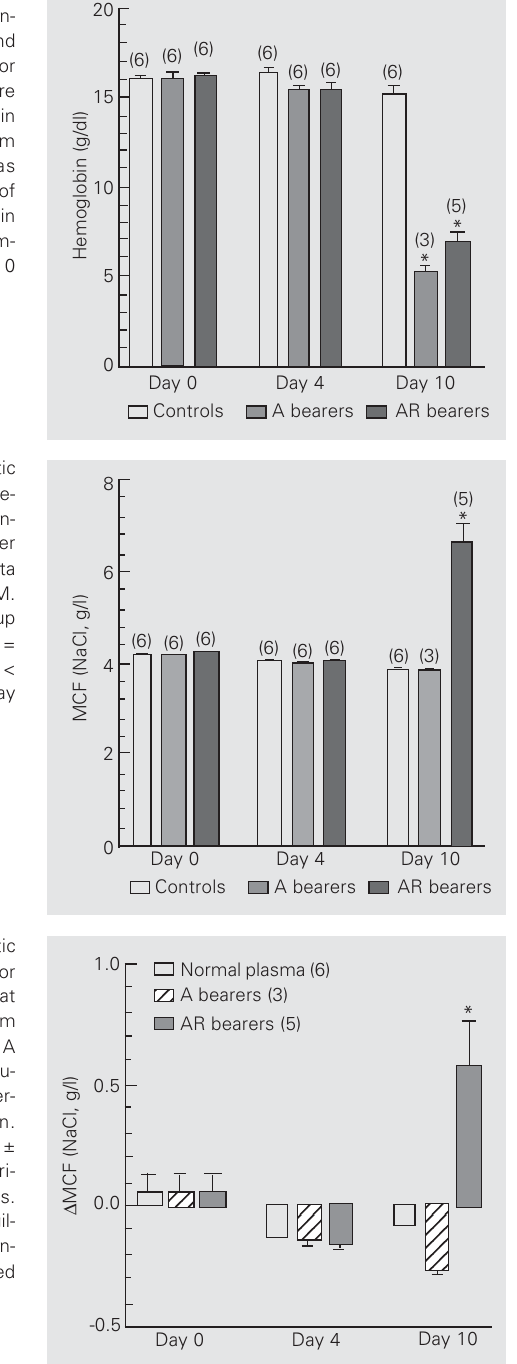
Figure 1. Development of ane- mia by splenectomized rats in- oculated multifocally with A and AR Walker 256 (W256) tumor cells. Tumor cells (5 x 10 6 ) were simultaneously inoculated sc in four dorsal sites at least 1 cm apart. Data are reported as means ± SEM. The number of rats in each group is given in parentheses. *P < 0.01 com- pared to control on day 10 (paired Student t -test).